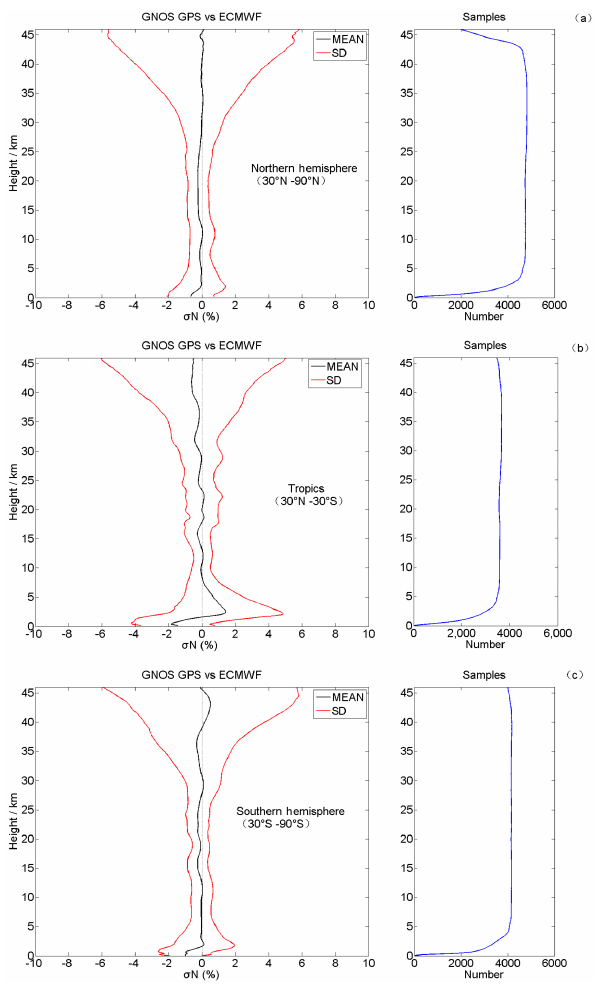
Figure 10. Comparisons of GNOS GPS refractivity with ECMWF reanalysis: (a) for the Northern Hemisphere (30–90 ◦ N), (b) for the tropics (30 ◦ N–30 ◦ S), and (c) for the Southern Hemisphere (30– 90 ◦ S). The left of each panel shows the mean bias (black) and the standard deviation (red), while the right of each panel shows the samples used vs. altitude (from 1 November to 31 December 2013).